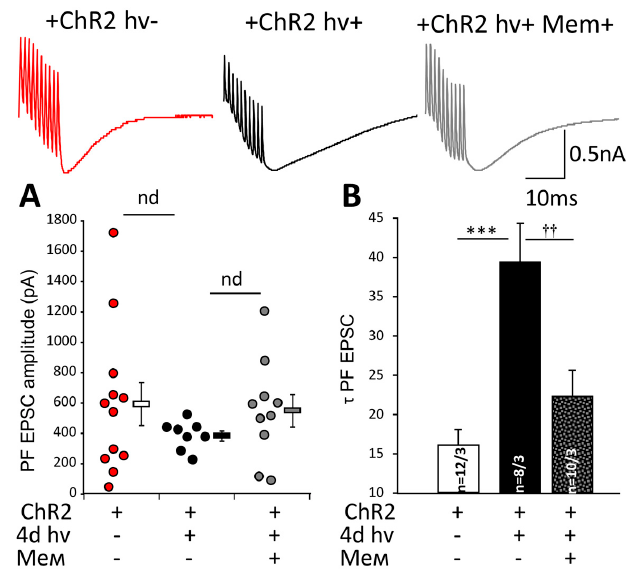
Figure 4. Chronic photostimulation of BGChR2 affects PF-PCs synaptic transmission. To assess the